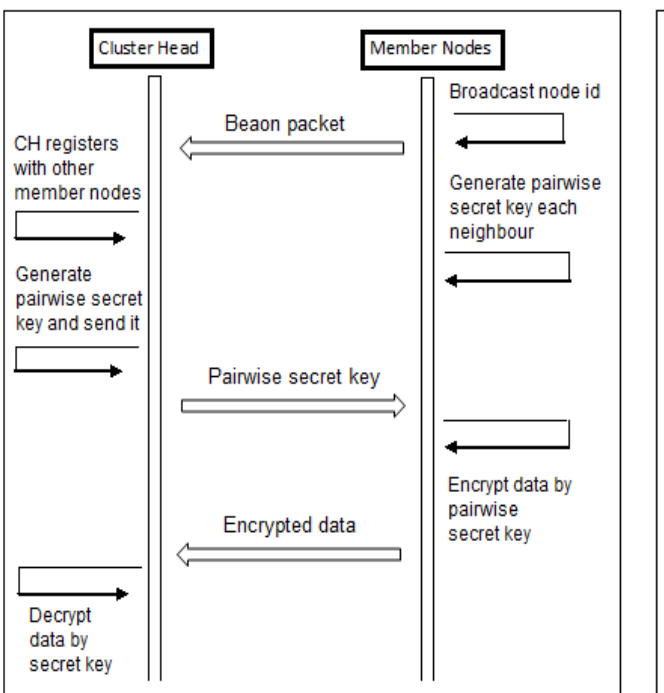
Figure 3. Sequence diagram of secure